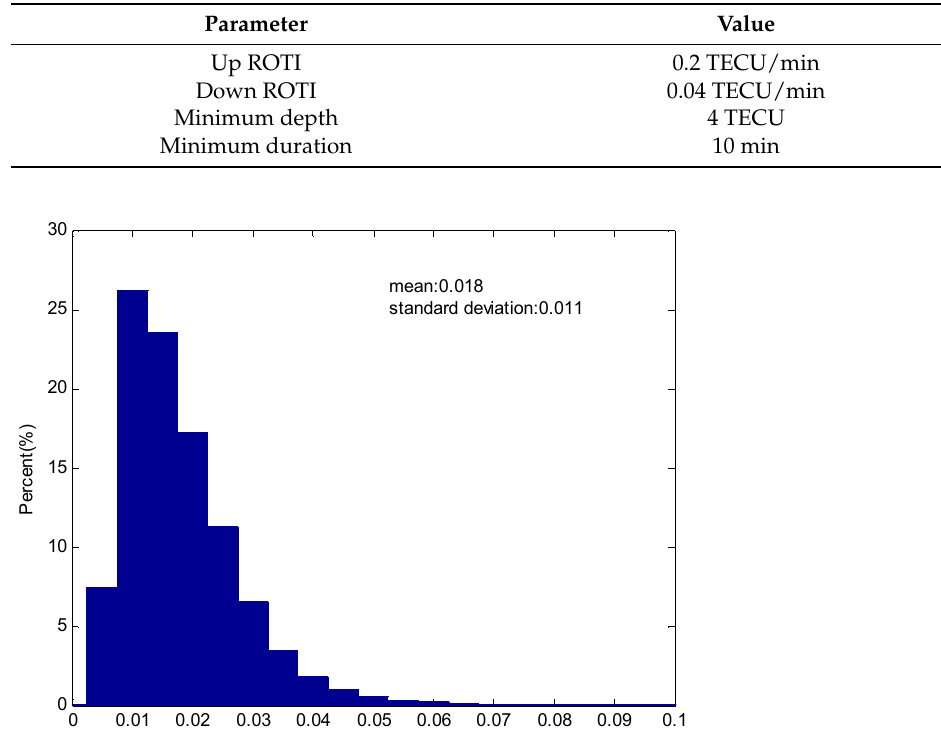
Figure 1. Diagram for the partial fitting strategy. The blue line shows the synthesized TEC time series including EPB signals during the period of (T1, T2). The red line shows the data for fitting. The green line shows the fitted TEC time series. Table 1. Parameters of the ROTI-aided EPBs detection method.